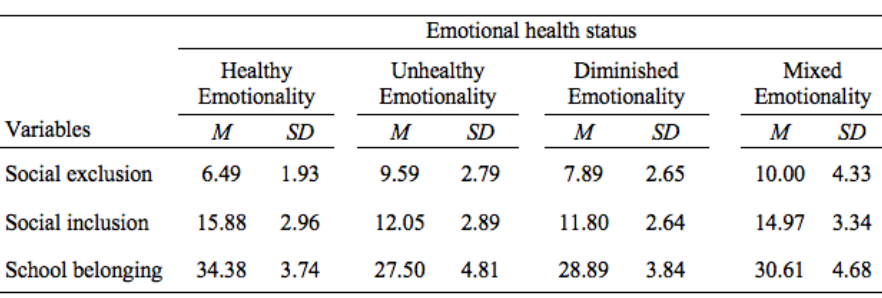
School belonging and emotional health status of participants